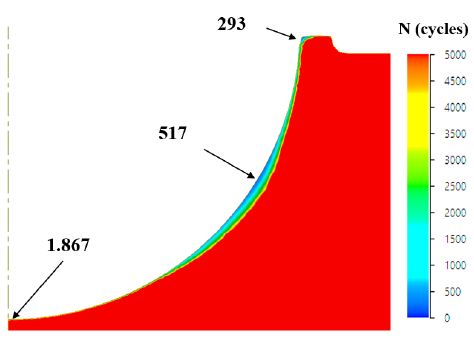
Figure 6. Prediction of the number of cycles for the onset of thermal fatigue.